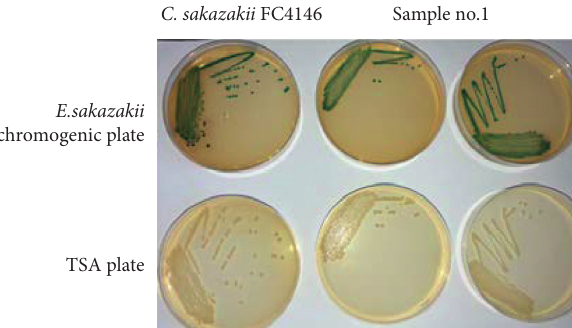
Figure 12: The colonies of C. sakazakii and the no. 1 bacterium detected in Flammulina velutipes . Table 3: The biochemical identification of the bacterium detected in Flammulina velutipes . Sample